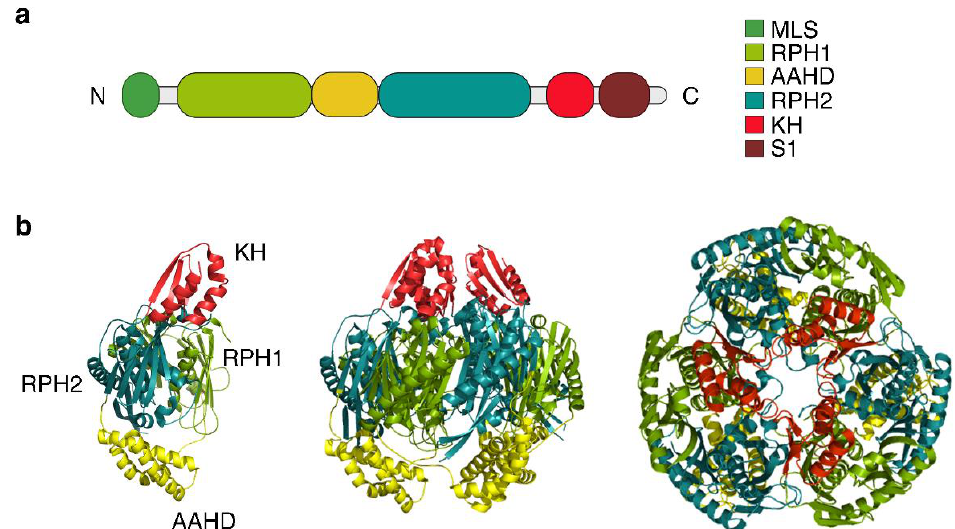
Figure 2. Structure of hPNPase. ( a ) Domain organization. The boxes represent the five evolutionarily conserved motifs that include MLS, mitochondrial localization sequence; AAHD, All α -helical domain; RPH1, Ribonuclease PH domain 1; RPH2, Ribonuclease PH domain 2; KH, K homology domain; S1, S1 domain. N, N-terminus; C, C-terminus. Created with Biorender.com. Available online: https://biorender.com/ (accessed on 27 January 2022). ( b ) Structure of monomeric (left) and trimeric (central, side view, and right, top view) truncated (devoid of S1 domain) hPNPase (PDB ID: 3U1K). The domains are colored as in panel a.